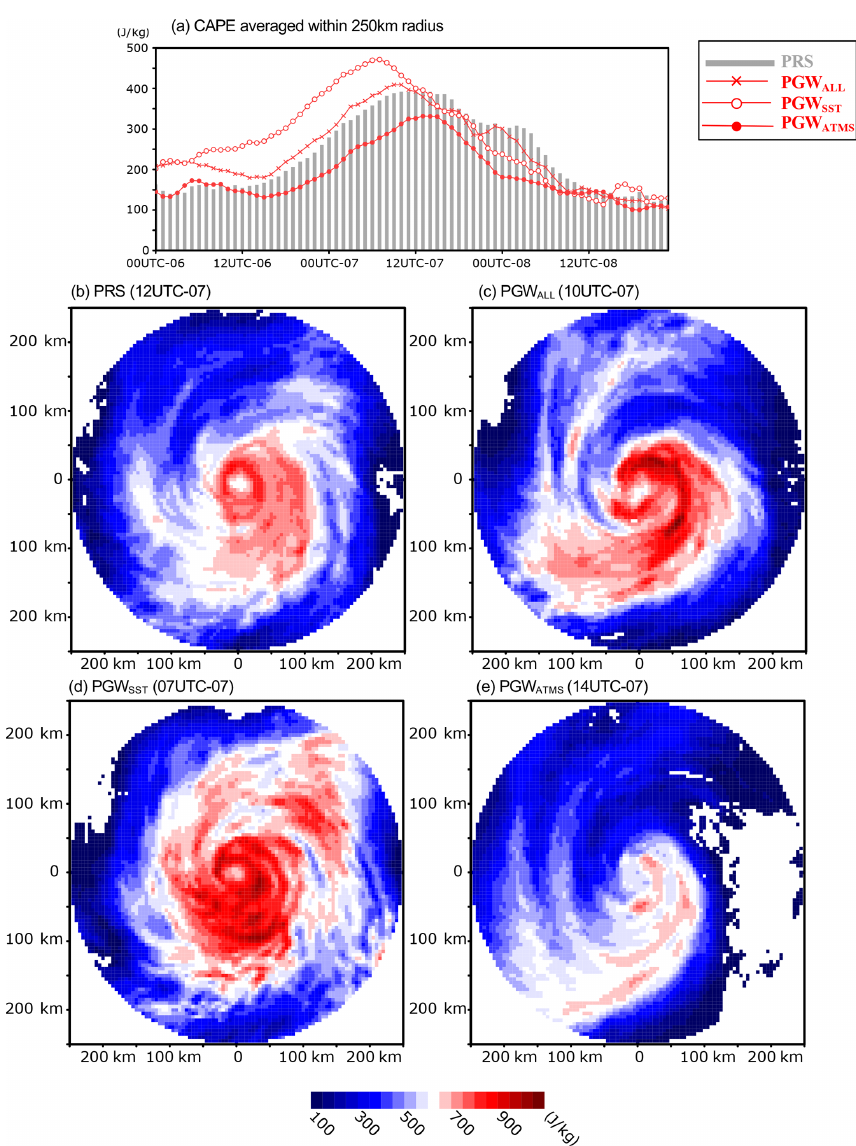
Figure 11. (a) Same as Fig. 6b, but for convective available potential energy (CAPE) and CAPE at its minimum (referring to Fig. 10a) for (b) PRS, (c) PGW ALL , (d) PGW SST , and (e) PGW ATMS around the cyclone